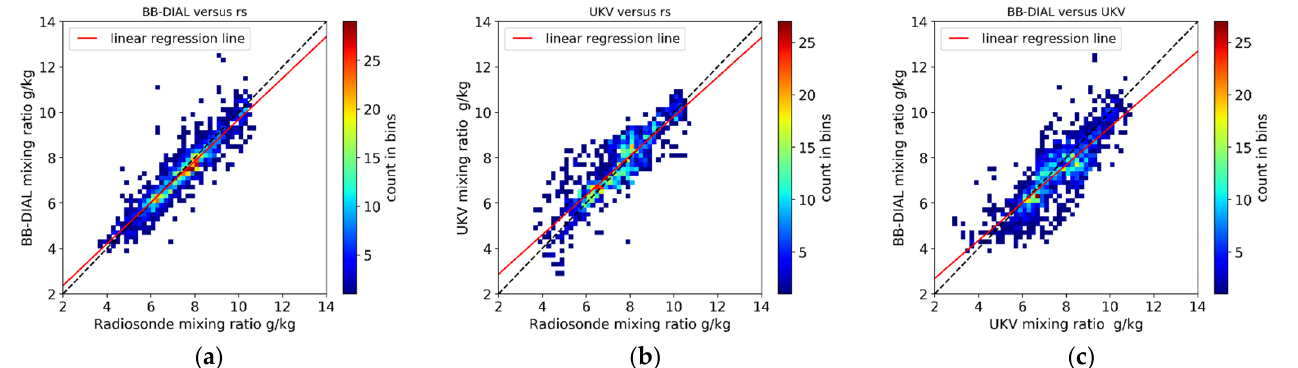
Figure 17. Scatter plots (in the form of 2D histograms). Note that the radiosonde data have been averaged at the BB-DIAL resolution (as provided by Newsom et al. 2020) at each model level and value below 50 m have been excluded. ( a ) BB-DIAL versus radiosonde. ( b ) UKV versus radiosonde. ( c ) BB-DIAL versus UKV. Table 4. Statistical results corresponding with the scatter plots in Figure 17a,c.